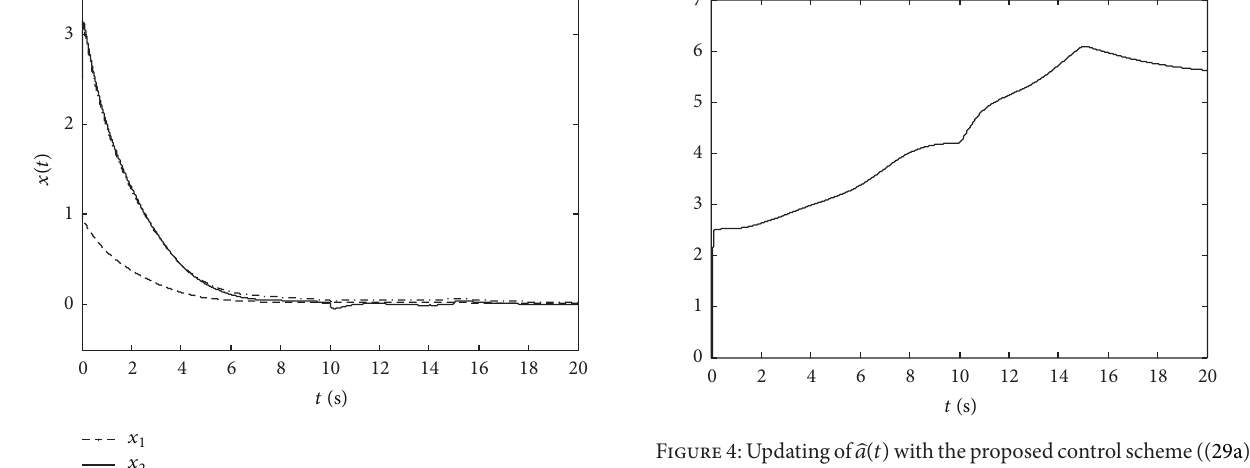
Figure4:Updatingof ̂𝑎(𝑡) withtheproposedcontrolscheme((29a), (29b), and (29c)).